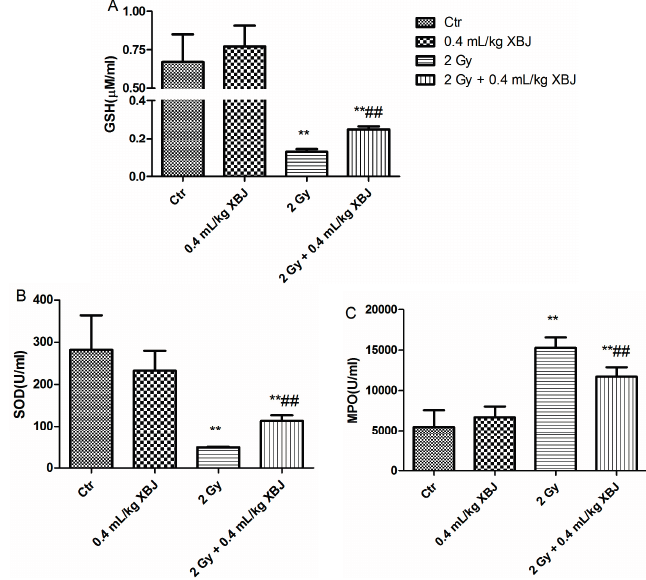
Figure 6. The effects of XBJ on the serum levels of GSH, SOD and MPO. Serum was collected from mice nine days after administration of 2 Gy TBI, and the enzyme levels were measured with the appropriate kits. ( A ) GSH levels; ( B ) SOD levels; ( C ) myeloperoxidase (MPO) levels. The data were expressed as the means ± SD ( n = 5). ** p < 0.01 vs . the control group; ## p < 0.05 vs . the IR